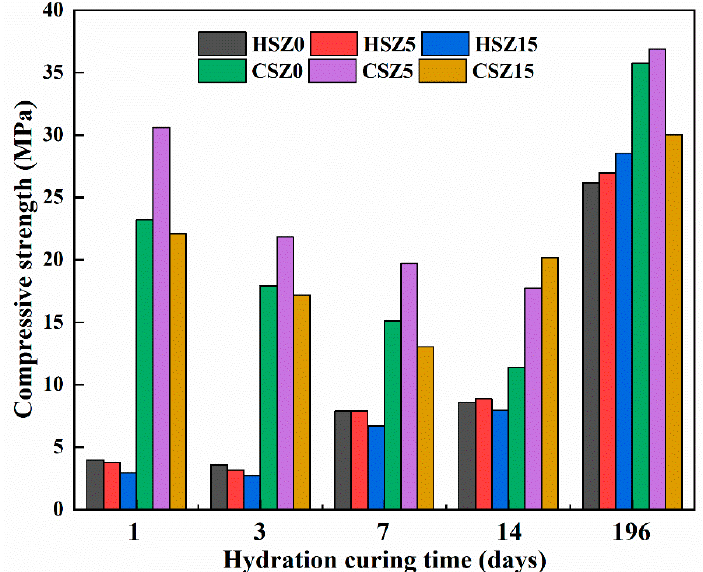
Figure 4. Compressive strength of SZ specimens after “H” or “C”. (H: hydration at different times; C: hydration at different times and then 2 h carbonation).